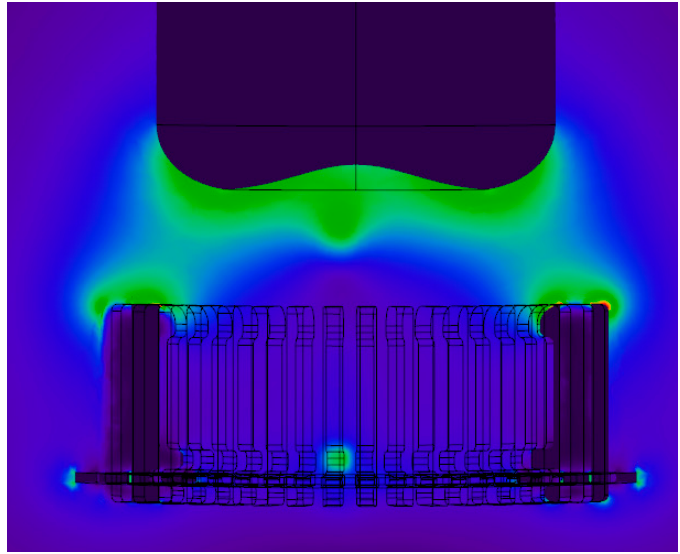
Figure 26. Electric field intensity distribution of large lamellas ( V/m ).